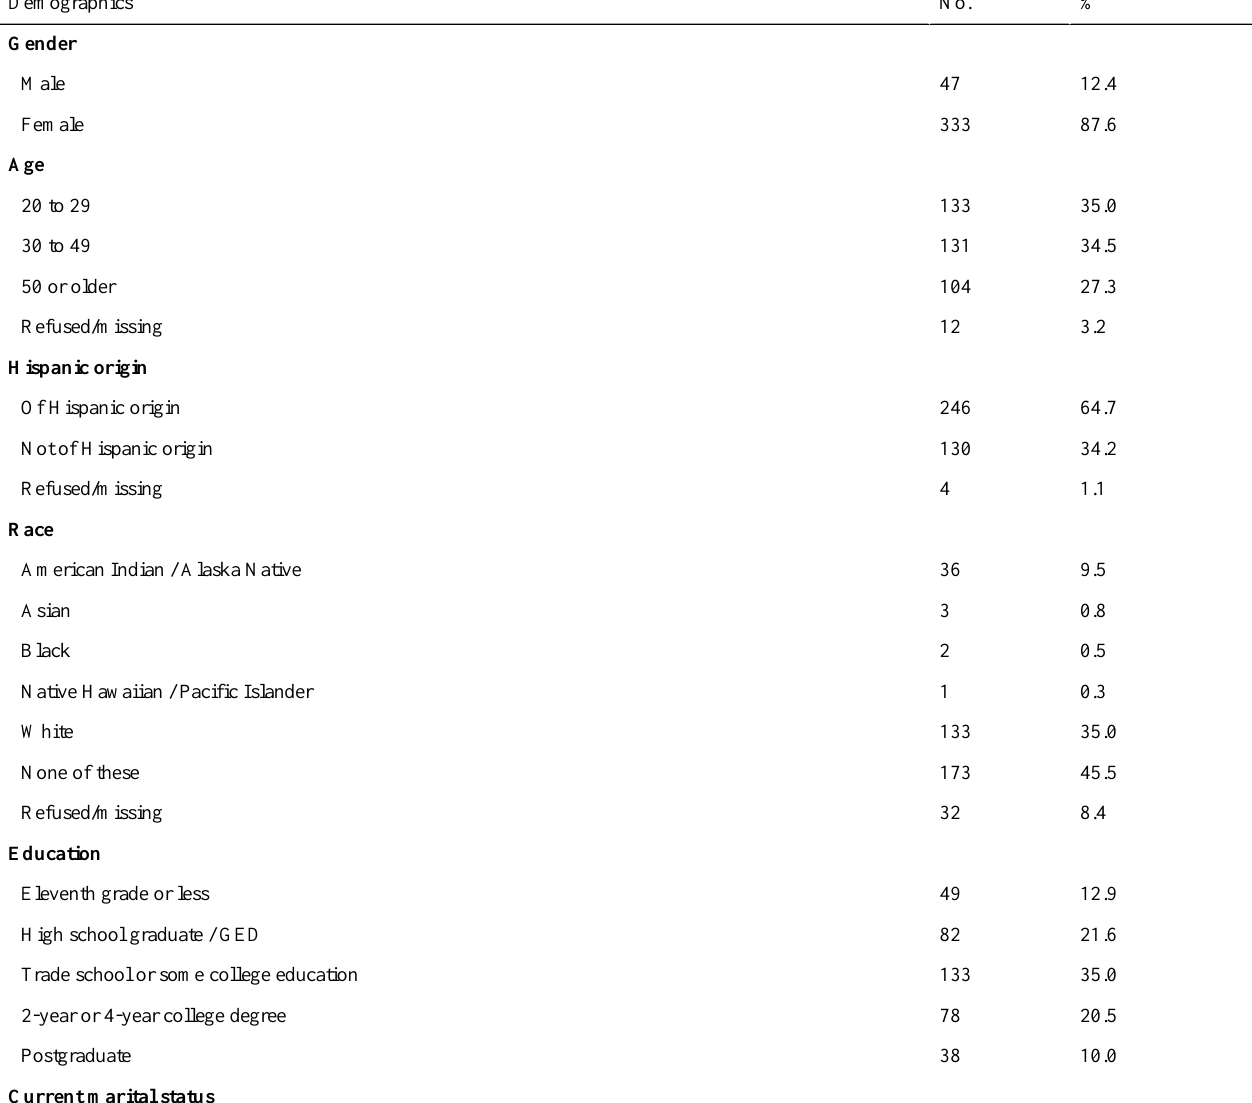
Table 1. Demographic characteristics and Internet experience of participants in the intervention group of the randomized trial (n =